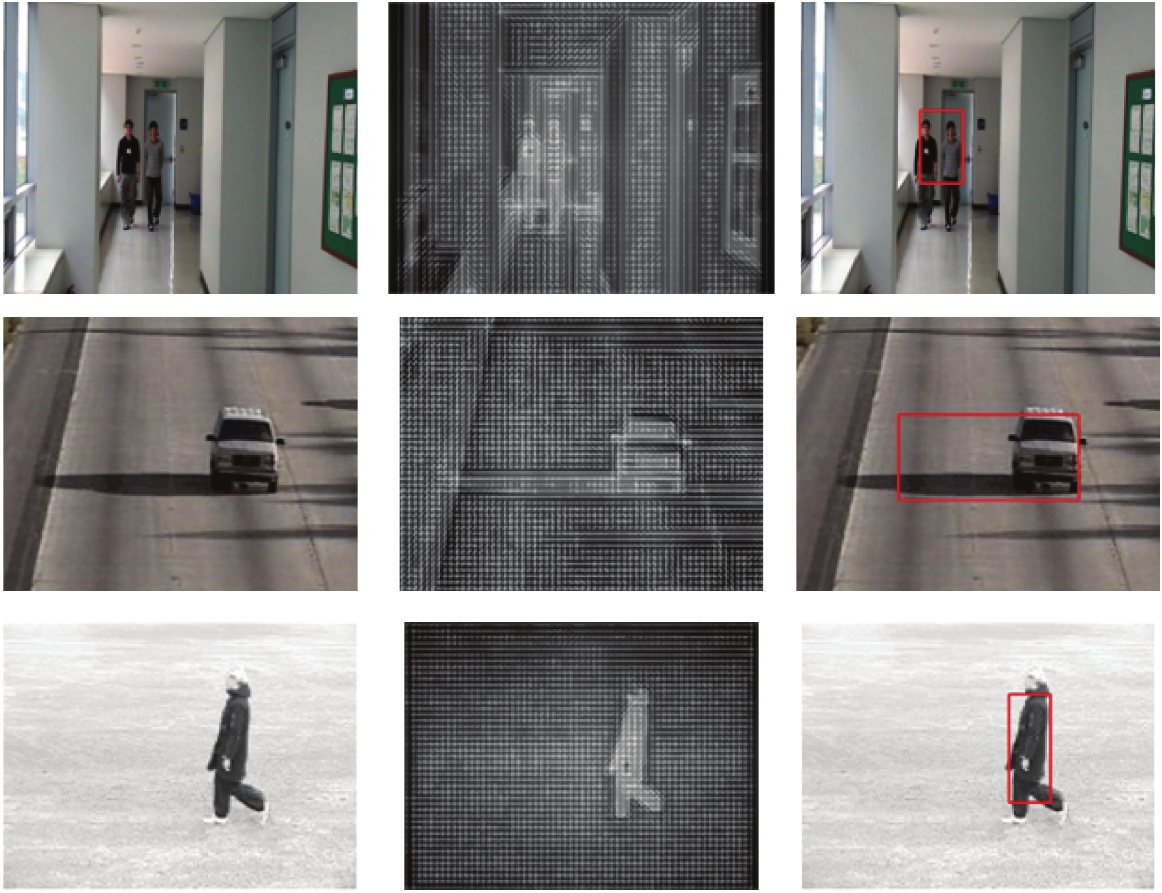
Figure 18: Videos (4), (5), and (6): results of integrating modified frequency tuned spatial model I with histogram of oriented gradient (HOG) [48].